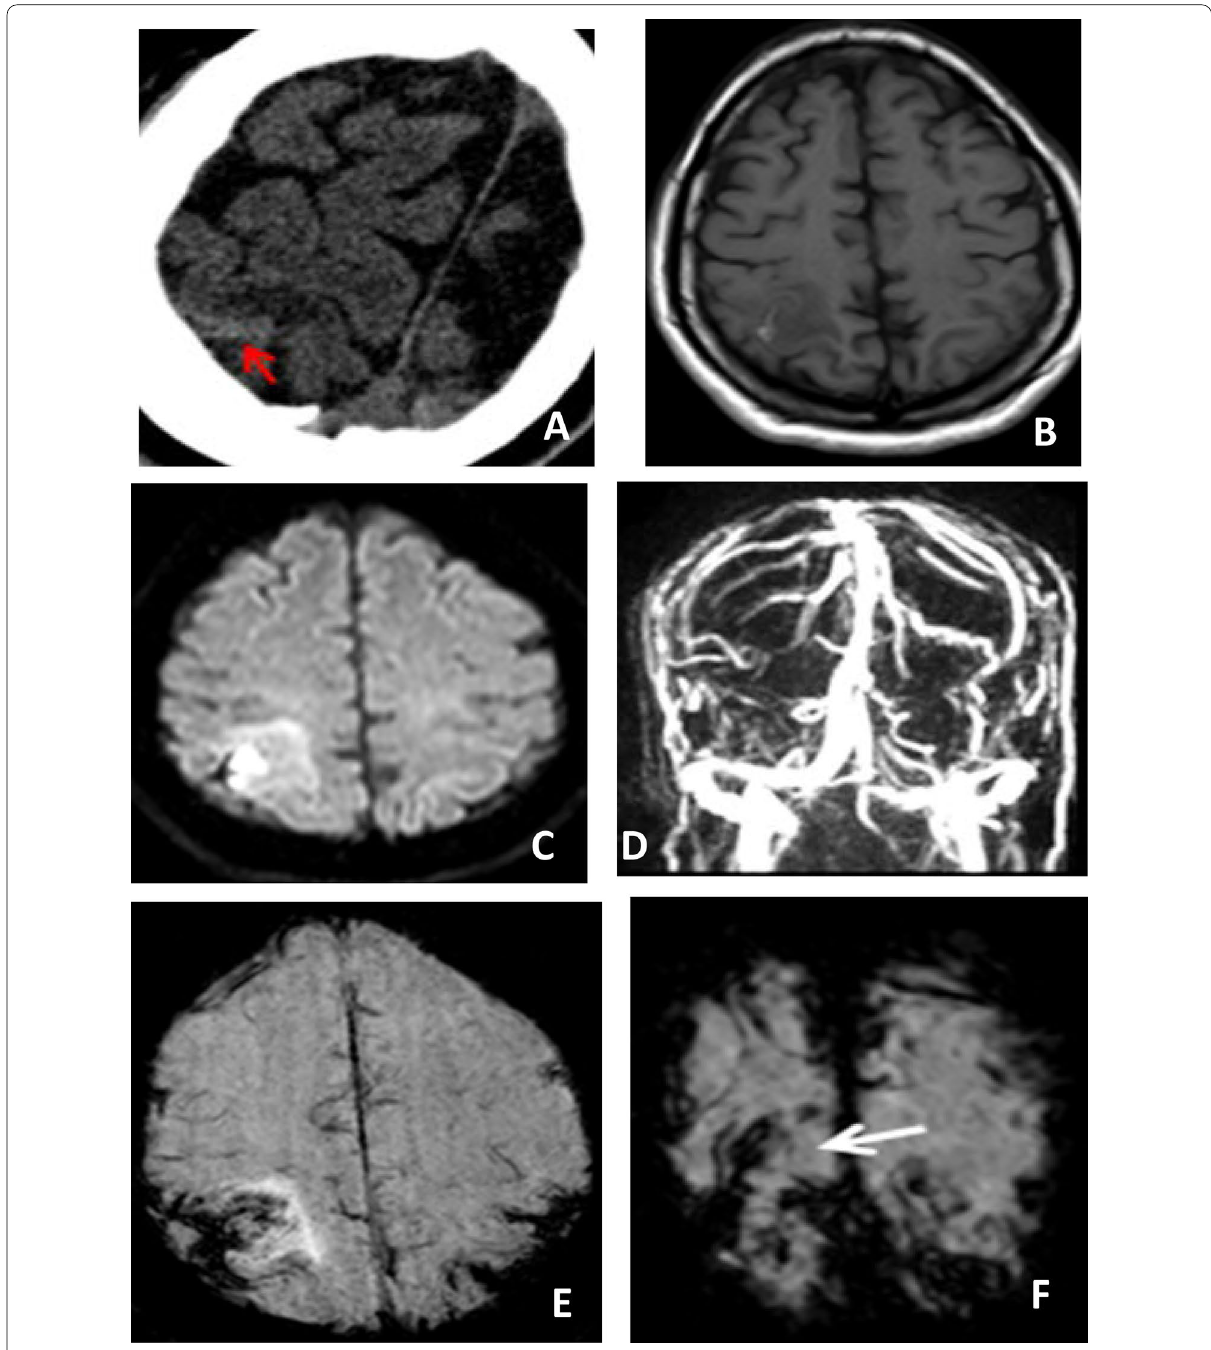
Fig. 4 A male children presented with neurological manifestations, CT was done at first, then one day later with a worsening patient symptom, MRI was done, and it revealed venous infarction secondary to cortical vein thrombosis. A CT study axial cut performed one day before MRI revealed a subtle undiagnosed right-sided hyperdense cortical vein (red arrow). B MRI study was done the following day with worsening patient symptoms and T1 WI ( B ) showed a right high frontal lesion of low signal with faint hyperintense signal within. C DWI showed restricted diffusion. D MRV study was normal. E , F SWI showed a hemorrhagic venous infarction ( E ) with prominent thrombosed cortical veins higher up (white arrow) ( F